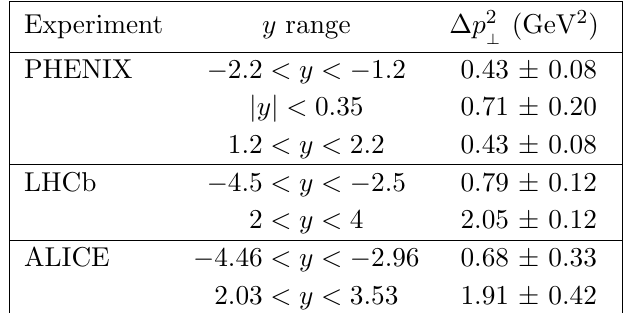
Table 5 . Determination of (cid:1) p 2